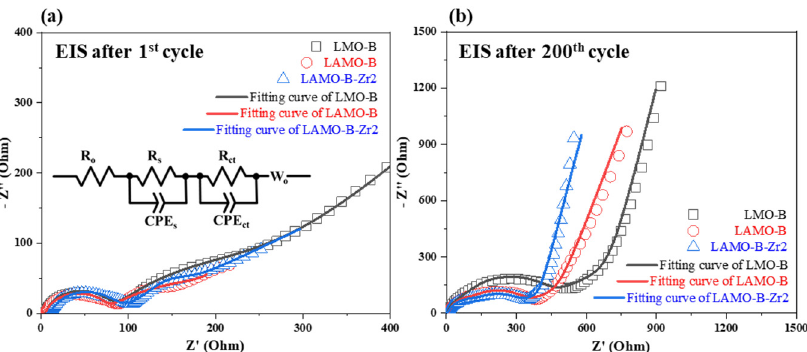
Figure 8. The Nyquist plots of the LMO-B, LAMO-B, and LAMO-B-Zr2 cells after the ( a ) 1st and ( b ) 200th cycle over the frequency range of 10 5 to 10 − 2 Hz. Inset figure is the equivalent circuit. Table 3. The fitting results of the LMO-B, LAMO-B, and LAMO-B-Zr2 cells after the 1st and 200th cycle.